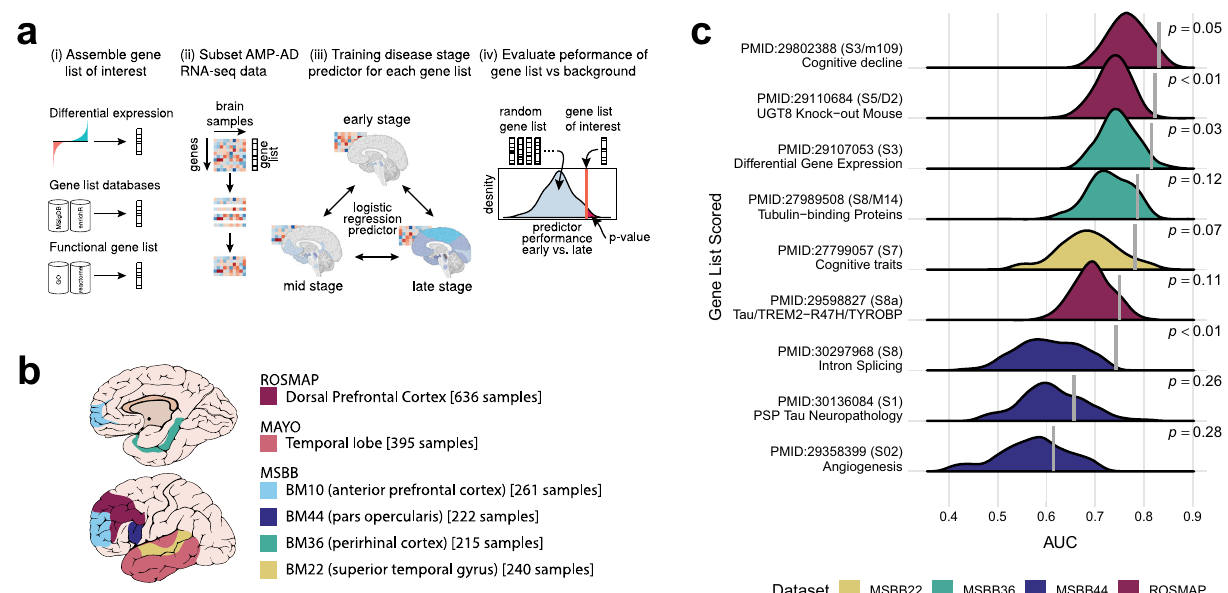
Fig. 1 The de fi nition and validation of the DRIAD framework. a Overview of the machine learning framework used to establish potential associations between gene lists and Alzheimer ’ s disease. (i) The framework accepts as input gene lists derived from experimental data or extracted from database resources or literature. (ii) Given a gene expression matrix, the framework subsamples it to a particular gene list of interest, and (iii) subsequently trains and evaluates through cross-validation a predictor of Braak stage of disease. (iv) The process is repeated for randomly selected gene lists of equal lengths to determine whether predictor performance associated with the gene list of interest is signi fi cantly higher than what is expected by chance. b AMP-AD datasets used by the machine learning framework. The three datasets used to evaluate the predictive power of gene lists are provided by The Religious Orders Study and Memory and Aging Project (ROSMAP), The Mayo Clinic Brain Bank (MAYO), and The Mount Sinai/JJ Peters VA Medical Center Brain Bank (MSBB). The schematic highlights regions of the brain that are represented in each dataset. The MSBB dataset spans four distinct regions, which are designated using Brodmann (BM) area codes. c Performance of predictors trained on gene lists reported in previous studies of AMP-AD datasets. The predictors are evaluated for their ability to distinguish early-vs-late disease stages with performance reported as area under the ROC curve (AUC). The vertical line on each row denotes predictor performance associated with a gene list reported in the literature, while the background distribution is constructed over randomly selected lists of matching lengths. Each row is annotated with the pubmed ID of the study, the supplemental resource that contained the gene list, and a short keyphrase providing functional context. Shown unadjusted p- values were computed with a one-sided empirical test, by counting the fraction of randomly selected lists in the background distribution that outperformed the corresponding literature